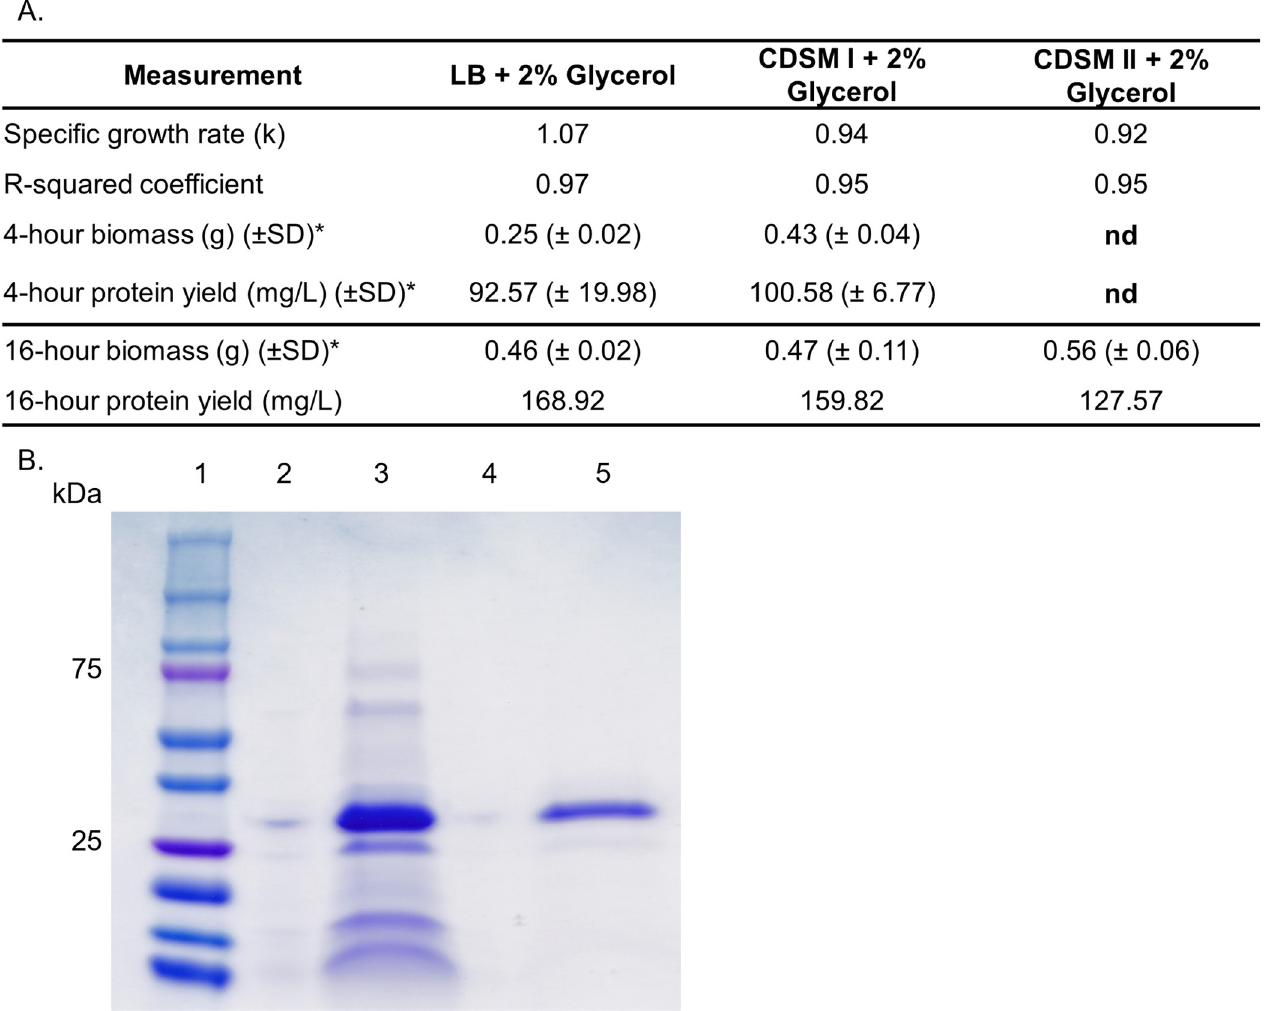
Fig 2. Protein expression and purification analysis. (A.) Table of growth characteristics, biomass, and protein yields. LB media; Lysogeny Broth baseline rich media. M9 media; minimal salts media. CDSM I; chemically defined spent media CHOgro 1 . CDSM II; chemically defined spent media Expi-CHO 1 . R 2 coefficient is the percentage of variability in the growth curve dataset that is accounted for by linear correlation between the OD600 (nm) and the time (hr). For the equation for the specific growth rate, see Methods. � n = 2 for all standard deviation calculations. (B.) SDS-PAGE analysis of purified protein versus input supernatant sample. Lane 1 = protein marker, lane 3 = post-boil supernatant sample from CDSM, lane 5 = purified monomeric fraction from size exclusion chromatography of CDSM. Full image available as S1 Raw images.